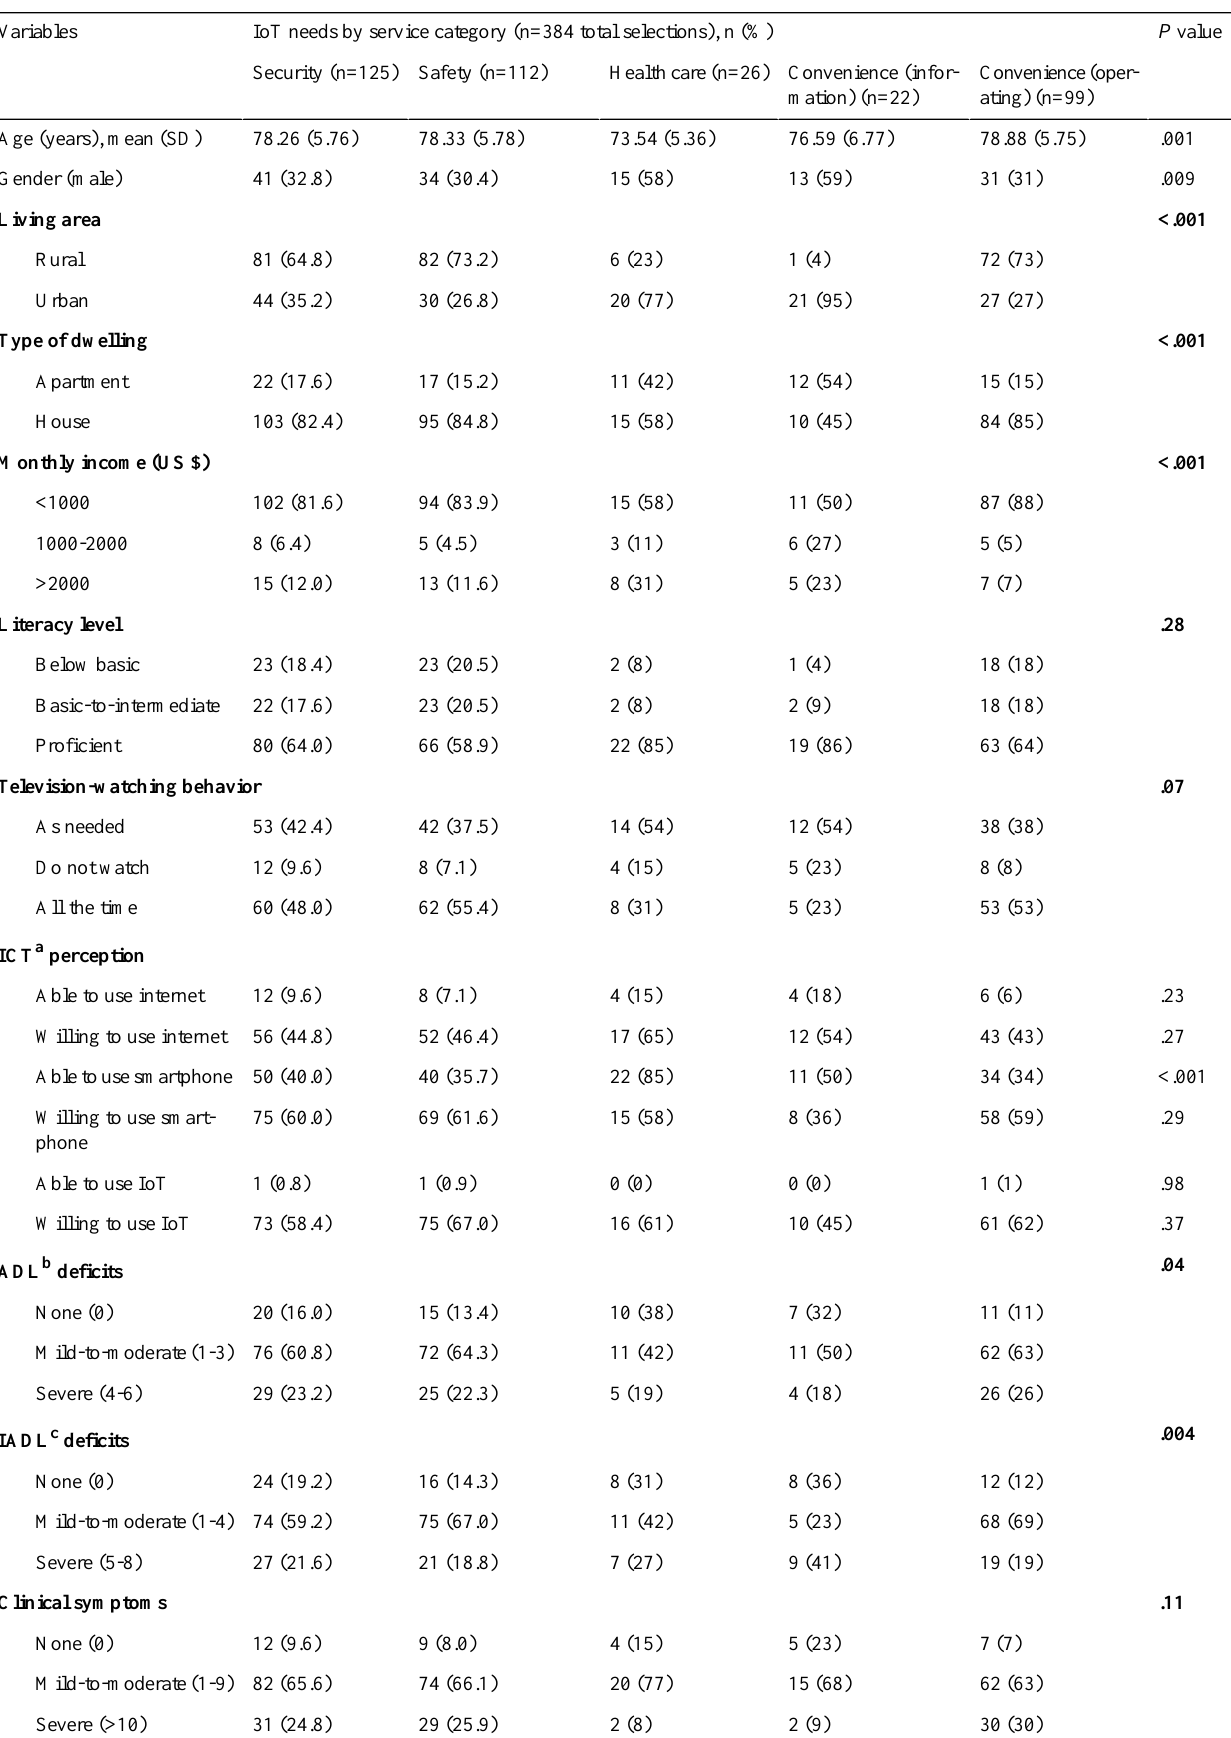
Table 4. Differences in underlying characteristics and conditions in terms of Internet of Things (IoT) category needs in older adults.